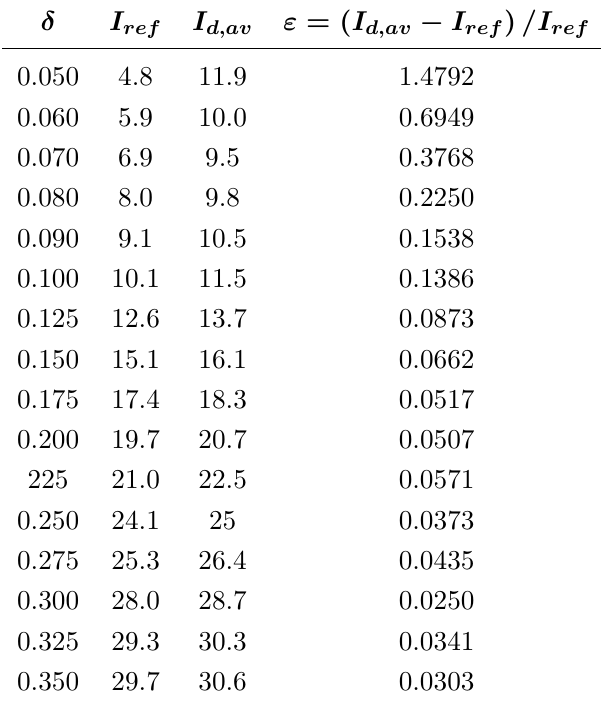
Table 7. Verifications of the proposed measurement